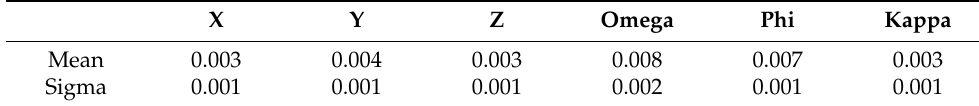
Table 1. Absolute camera position (m) and orientation (deg) error